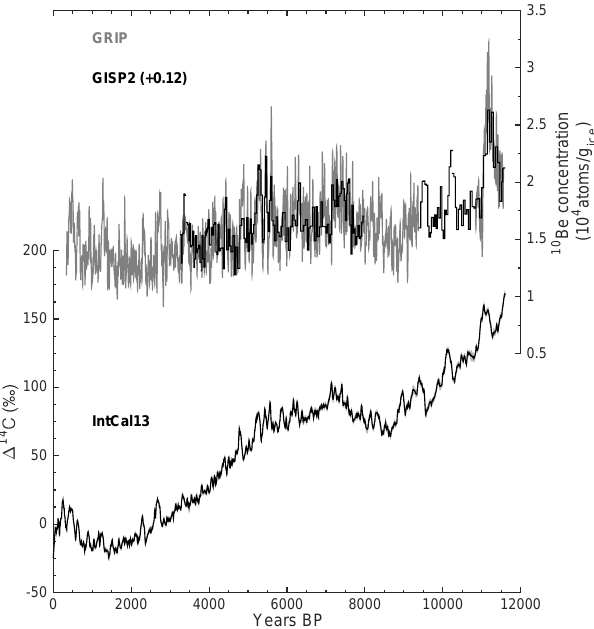
Figure 1. Top: GRIP (grey, Vonmoos et al., 2006) and GISP2 (black, Finkel and Nishiizumi, 1997) Holocene 10 Be concentra- tions. The GRIP 10 Be record is smoothed by a 61pt binomial filter (see Vonmoos et al., 2006). The GISP2 10 Be record has been shifted by + 0.12 × 10 4 atomsg − 1 to correct for a difference in the mean of the GRIP and GISP2 10 Be records. Bottom: atmospheric (cid:49) 14 C as reconstructed from tree rings (Reimer et al., 2013 and references